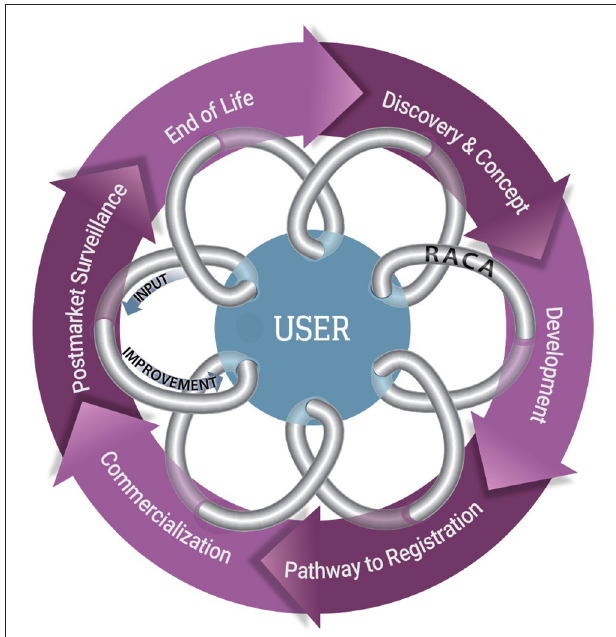
FIGURE 1 | The feedback loop for the TPLC for a commercialized clinical product. The TPLC for a commercialized clinical product, in general includes 6 primary steps that are often iterative in nature (purple circle). Manufacturers benefit from seeking input from users, such as pathologists and other healthcare providers, to continually introduce improvements and utility (arrows) into the product design. RACA professionals can be a conduit between users and industry (gray coil) to assist with delivering user input and communicating the implications of the